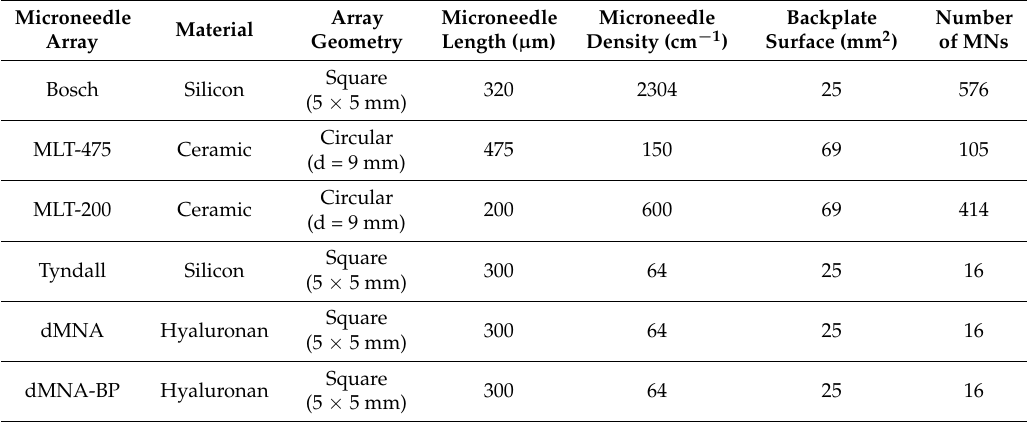
Table 1. Material and geometry of the microneedle arrays used in this study. Abbreviations: dissolving microneedle (dMNA); bi-layered back-plate (BP); microneedles